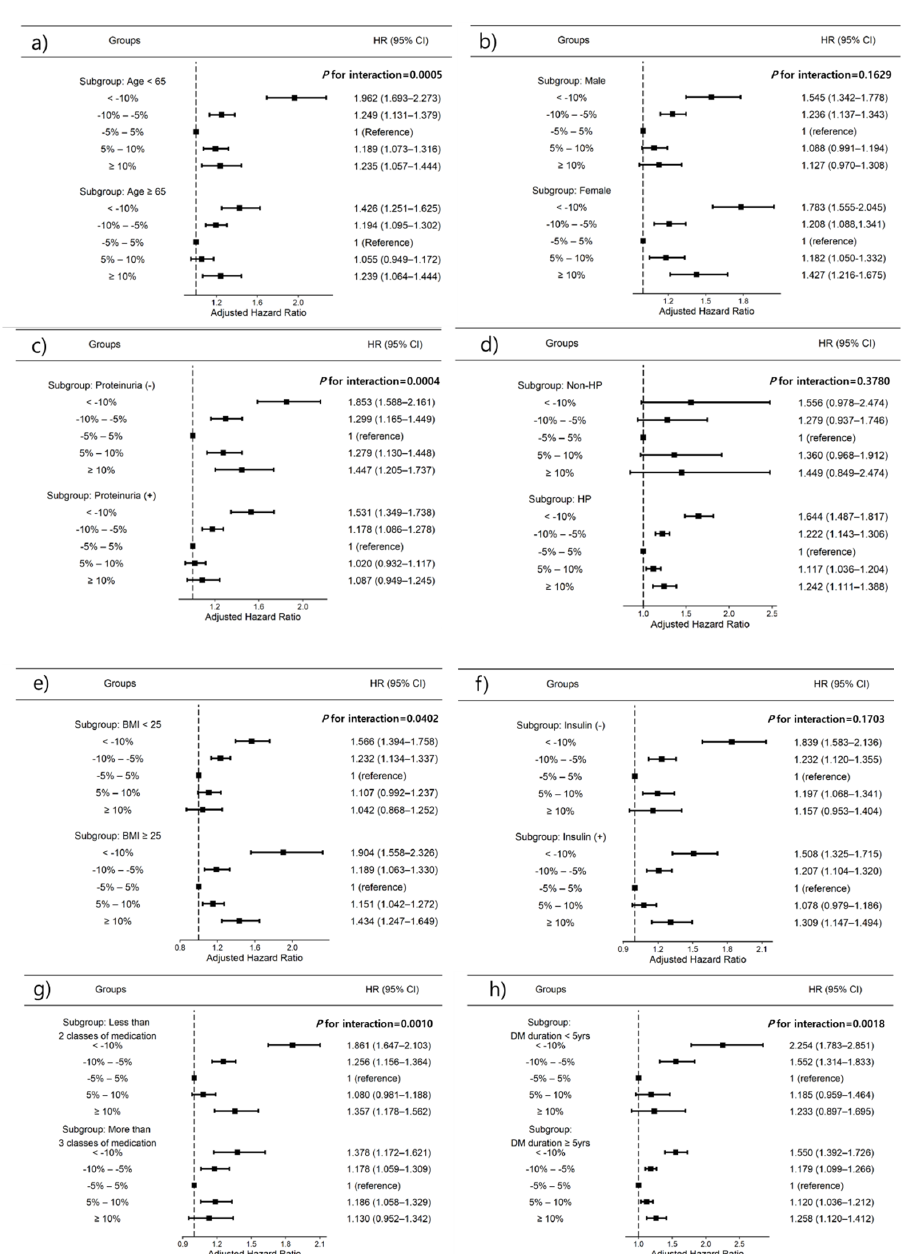
Figure 4. Subgroup analysis for adjusted hazard ratios (HRs) of ESRD. ( a ) Age subgroup, ( b ) sex subgroup, ( c ) history of proteinuria subgroup, ( d ) hypertension subgroup, ( e ) body mass index sub- group, ( f ) use of insulin subgroup, ( g ) use of more than three oral hypoglycemic agent subgroups,